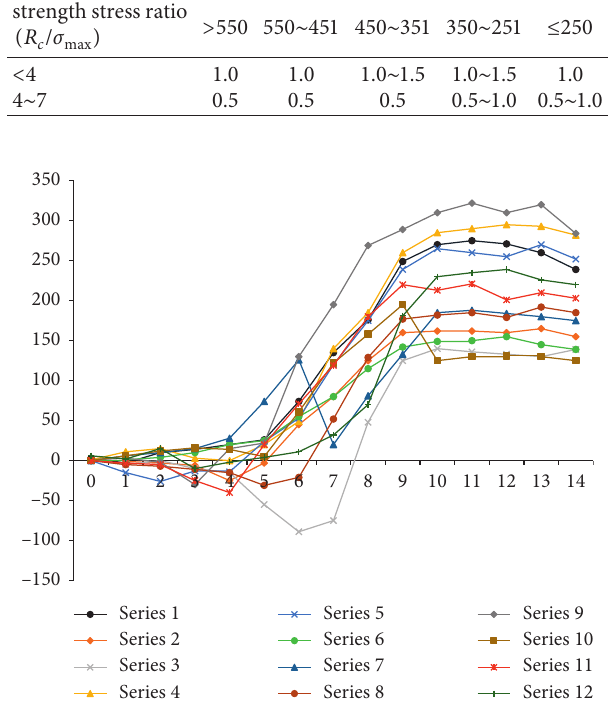
Figure 6: − 455m stress relief process curve of measuring point 7# in the horizontal middle section.